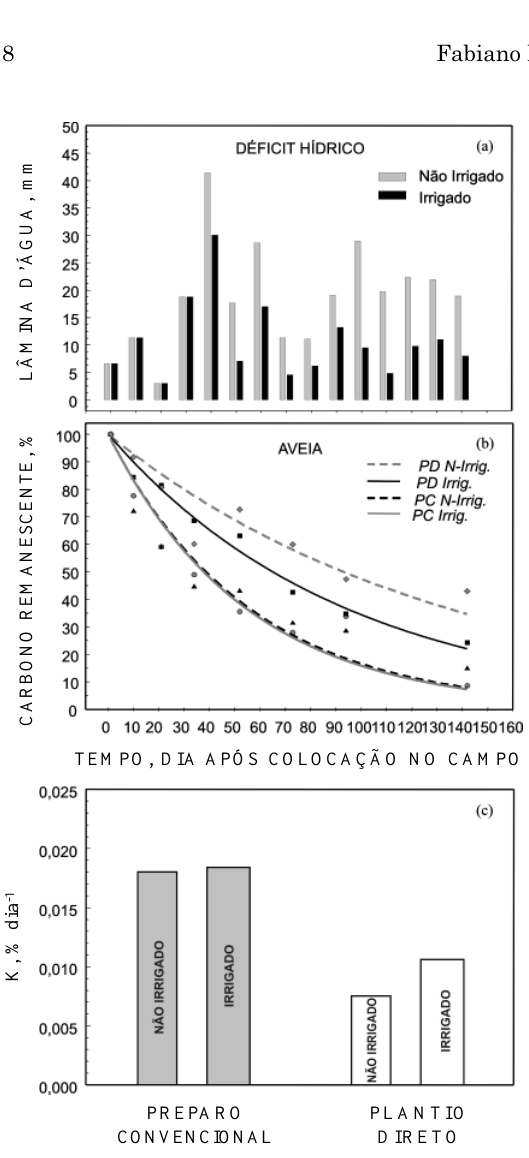
Figura 3. Déficit hídrico estimado para cultura da soja (a), carbono remanescente nos sacos de decomposição (b) e taxas diárias de decomposi- ção dos resíduos culturais de aveia ( k ) (c) no solo cultivado sob plantio direto (PD) e preparo convencional (PC), com (Irrig.) e sem irrigação (N-Irrig.) por